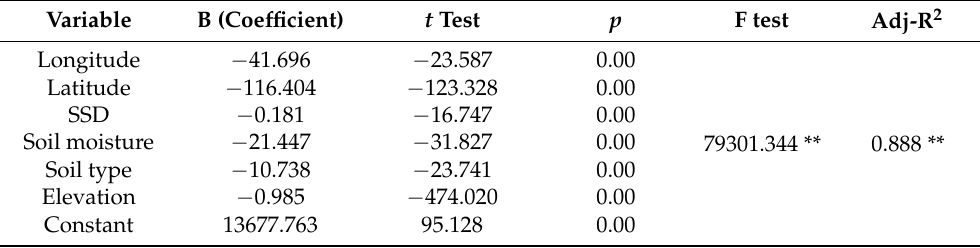
Table 3. Parameters of the multiple linear regression model constructed by GTI and explanatory vari- ables.